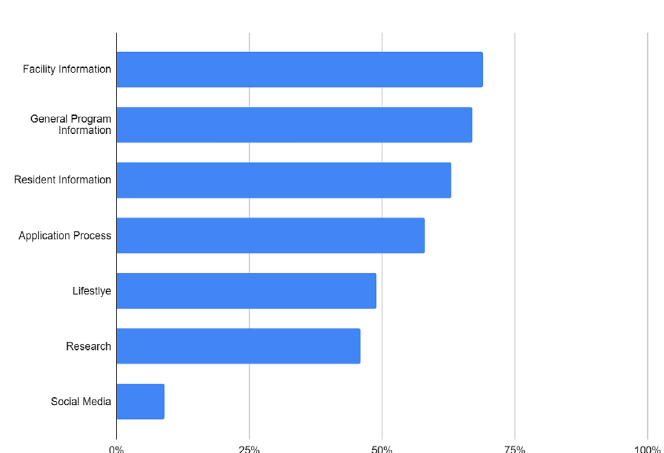
Figure 2. Content available on emergency medicine residency